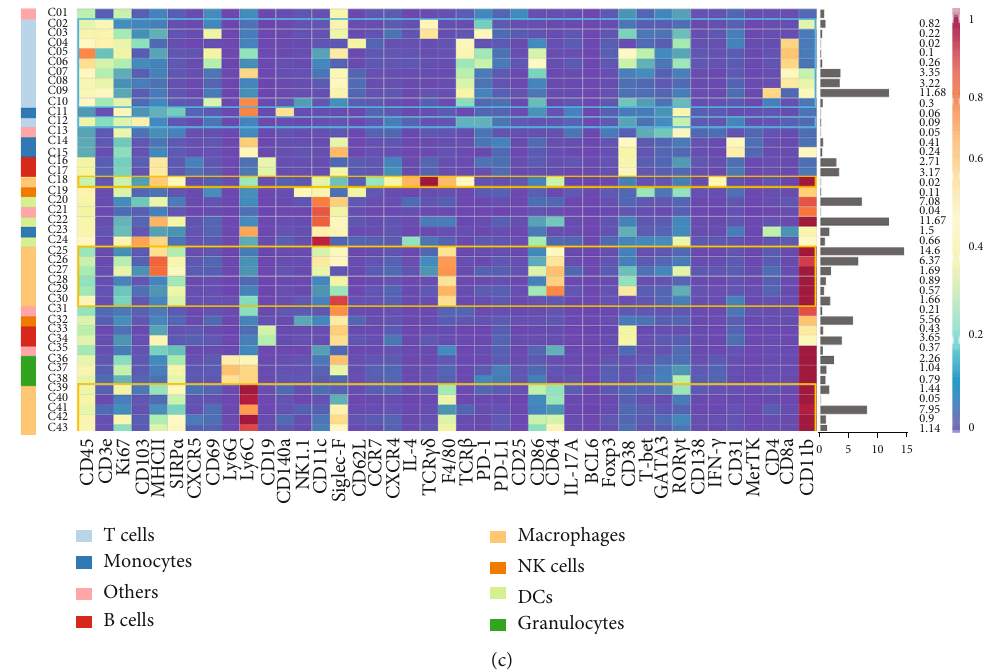
Figure 1: Characterization of immune cells in nephrolithiasis using mass cytometry. (a) Schematic showing how clusters are related to parent populations. (b) t-SNE maps displaying 9935 cells from the nephrolithiasis models analyzed with 42-antibody panel and colored by the main cell populations. (c) Heatmap showing normalized expression of the markers from 42-antibody panel for PhenoGraph clusters. Clusters are grouped by expression pro fi les, and cell types are indicated by color. The cluster IDs and relative frequencies are displayed as a bar graph on the